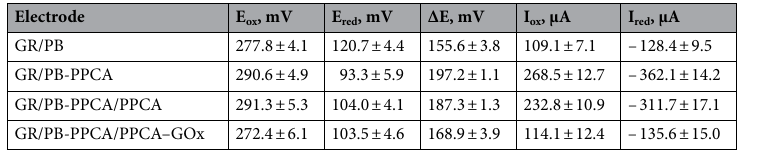
Table 1. Voltammetric parameters of different modified GR electrodes obtained in A-PBS-KCl, pH 6.0, at a scan rate of 0.1 V/s.